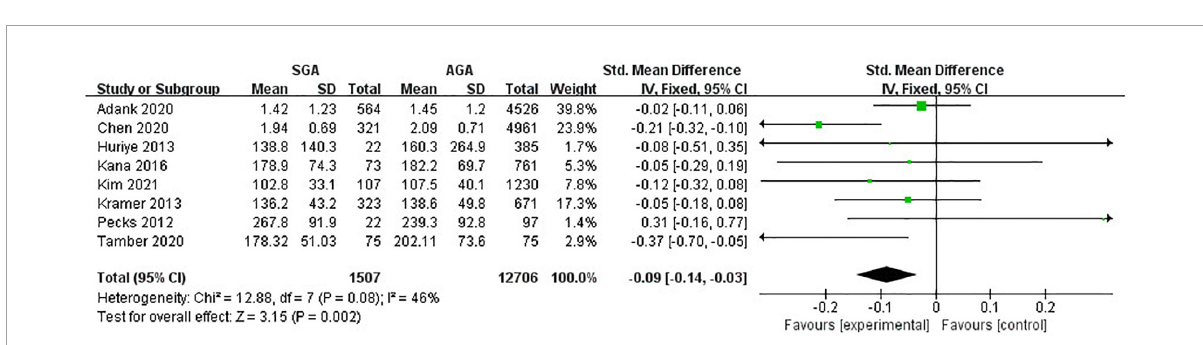
FIGURE3 Forest plot exploring the association between maternal TG levels and delivery of SGA. TG, triglycerides; SGA, small for gestational age.